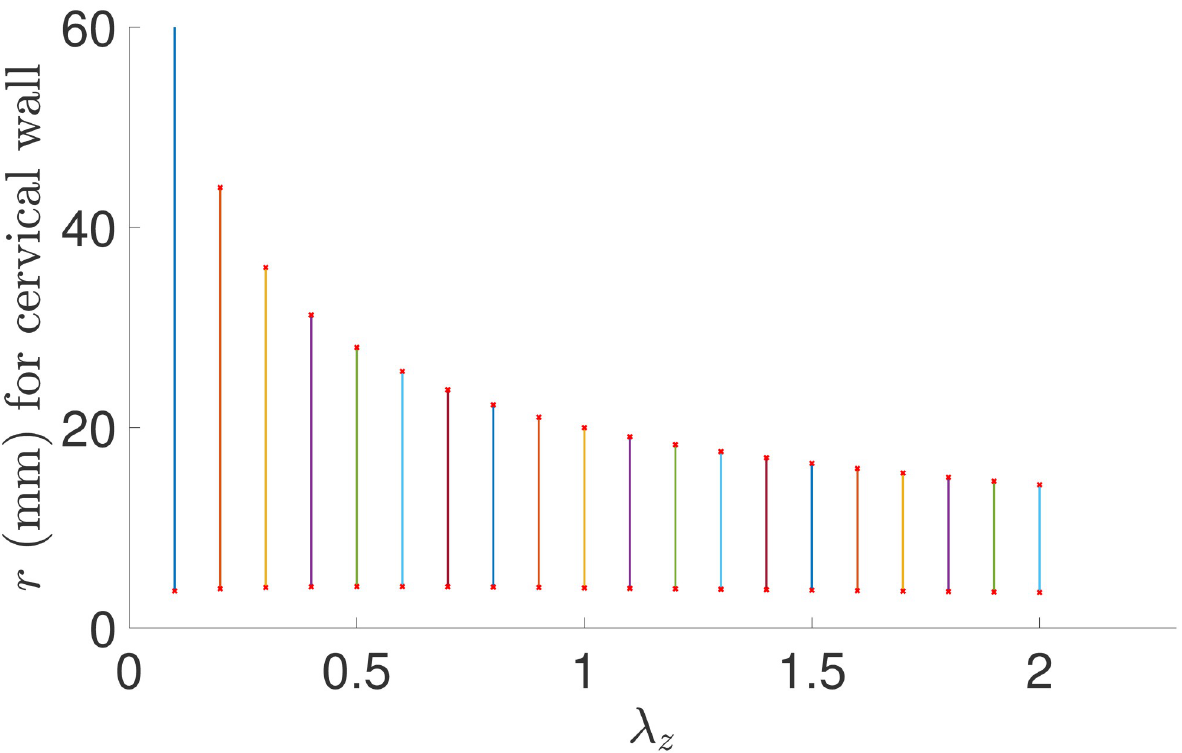
Fig 7. The cervical wall radius and thickness for the axial stretch parameter λ z over a continuous interval (0.1, 2). Interpretation of the vertical line intervals are the same as in Fig 6.